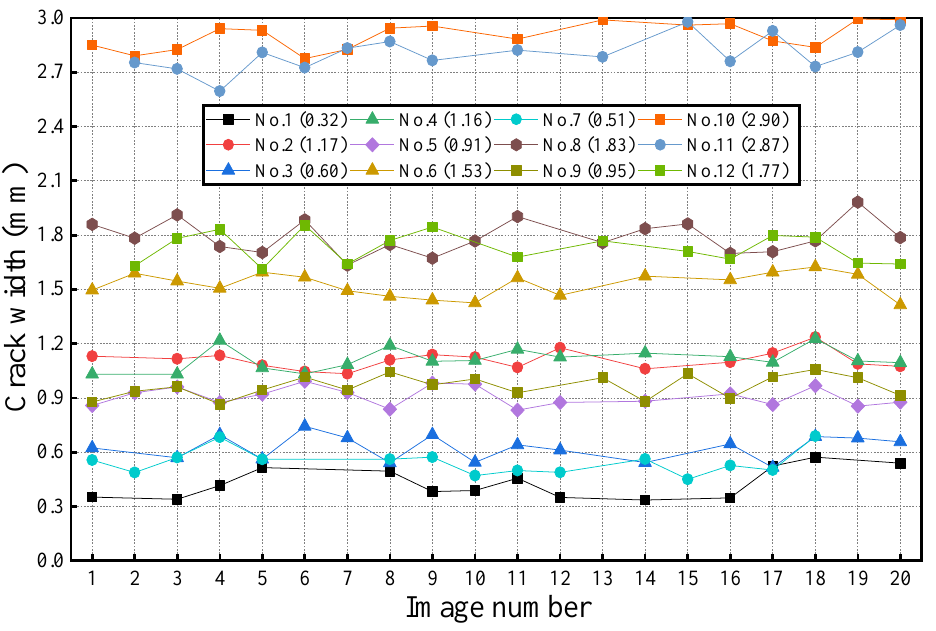
Figure 22. Measurement results of each crack in each image, and the real widths of 12 cracks. Of these, crack no. 1 is not detected in image 6, image 7 and image 19; crack no. 7 is not detected in image 6, image 7, image 19 and image 20.